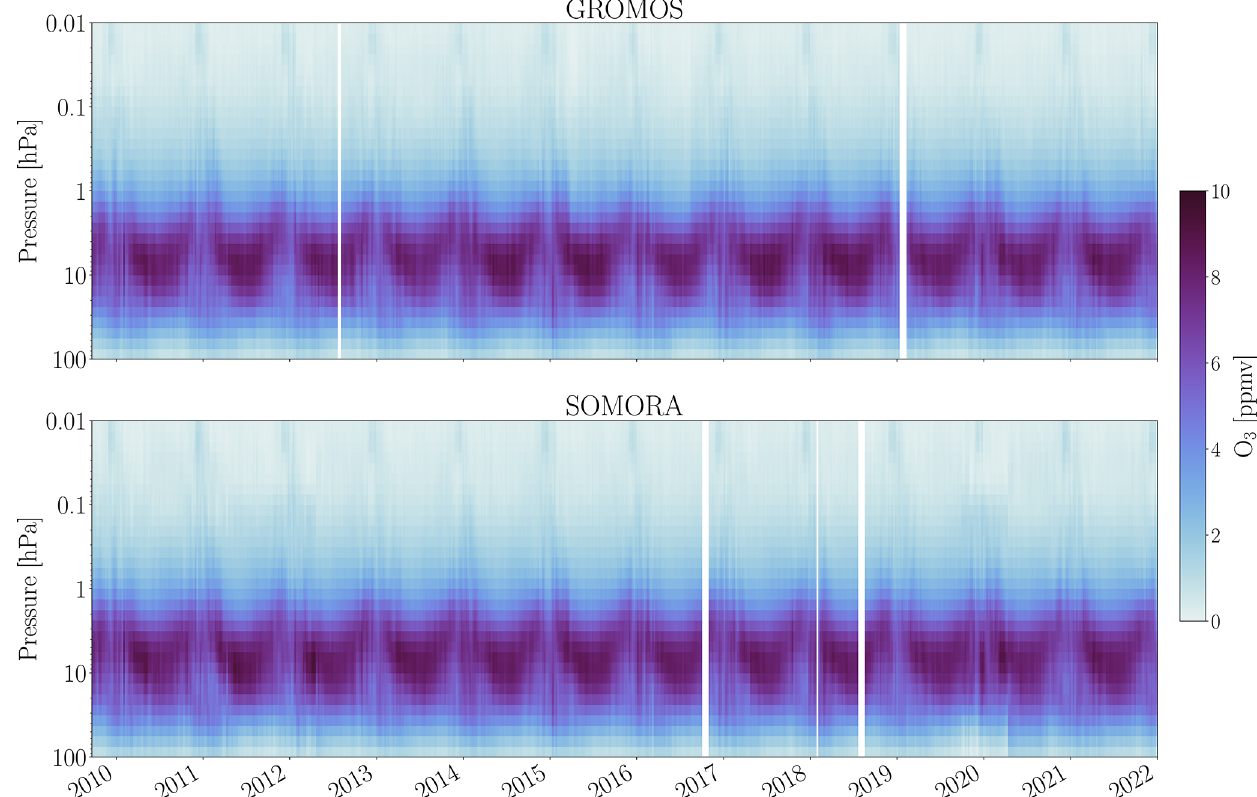
Figure 5. Weekly averaged ozone volume mixing ratio (VMR) profiles for GROMOS and SOMORA.